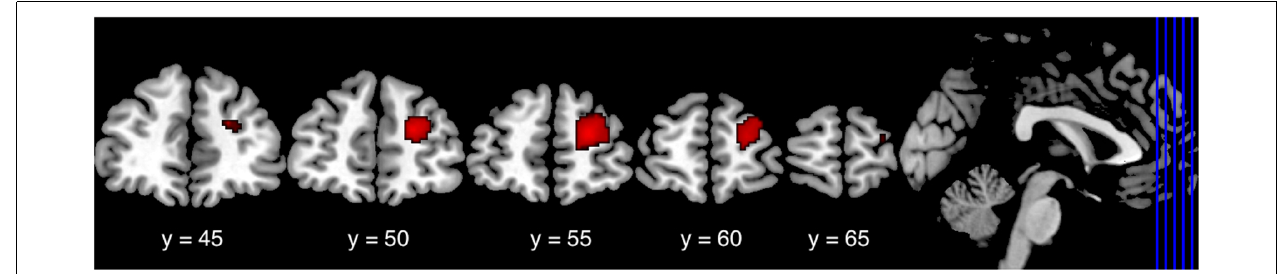
FIGURE 2 | Lower connectivity in the right lateral PFC cluster in Nurses. In functional connectivity analysis seeding the right striatum cluster, Nurses showed significantly lower functional connectivity between the right lateral PFC and the right striatum (cluster FDR p = 0.048) than did the Controls. Lateral PFC, lateral prefrontal cortex; FDR, false discovery